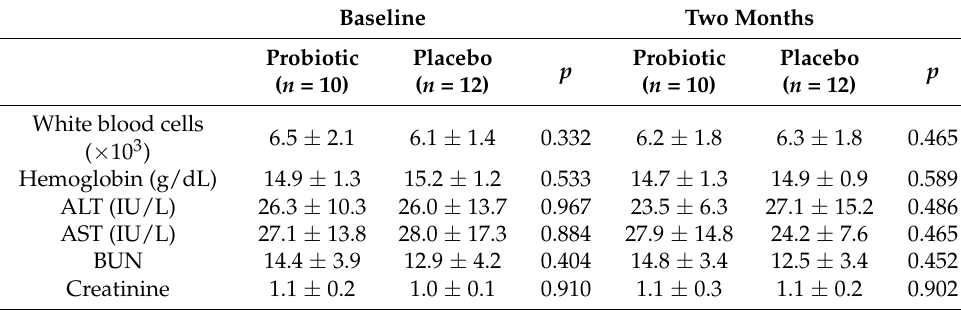
Baseline Two Months Probiotic Placebo Probiotic Placebo p p ( n = 10) ( n = 12) ( n = 10) ( n = 12) 6.5 ± 2.1 6.1 ± 1.4 0.332